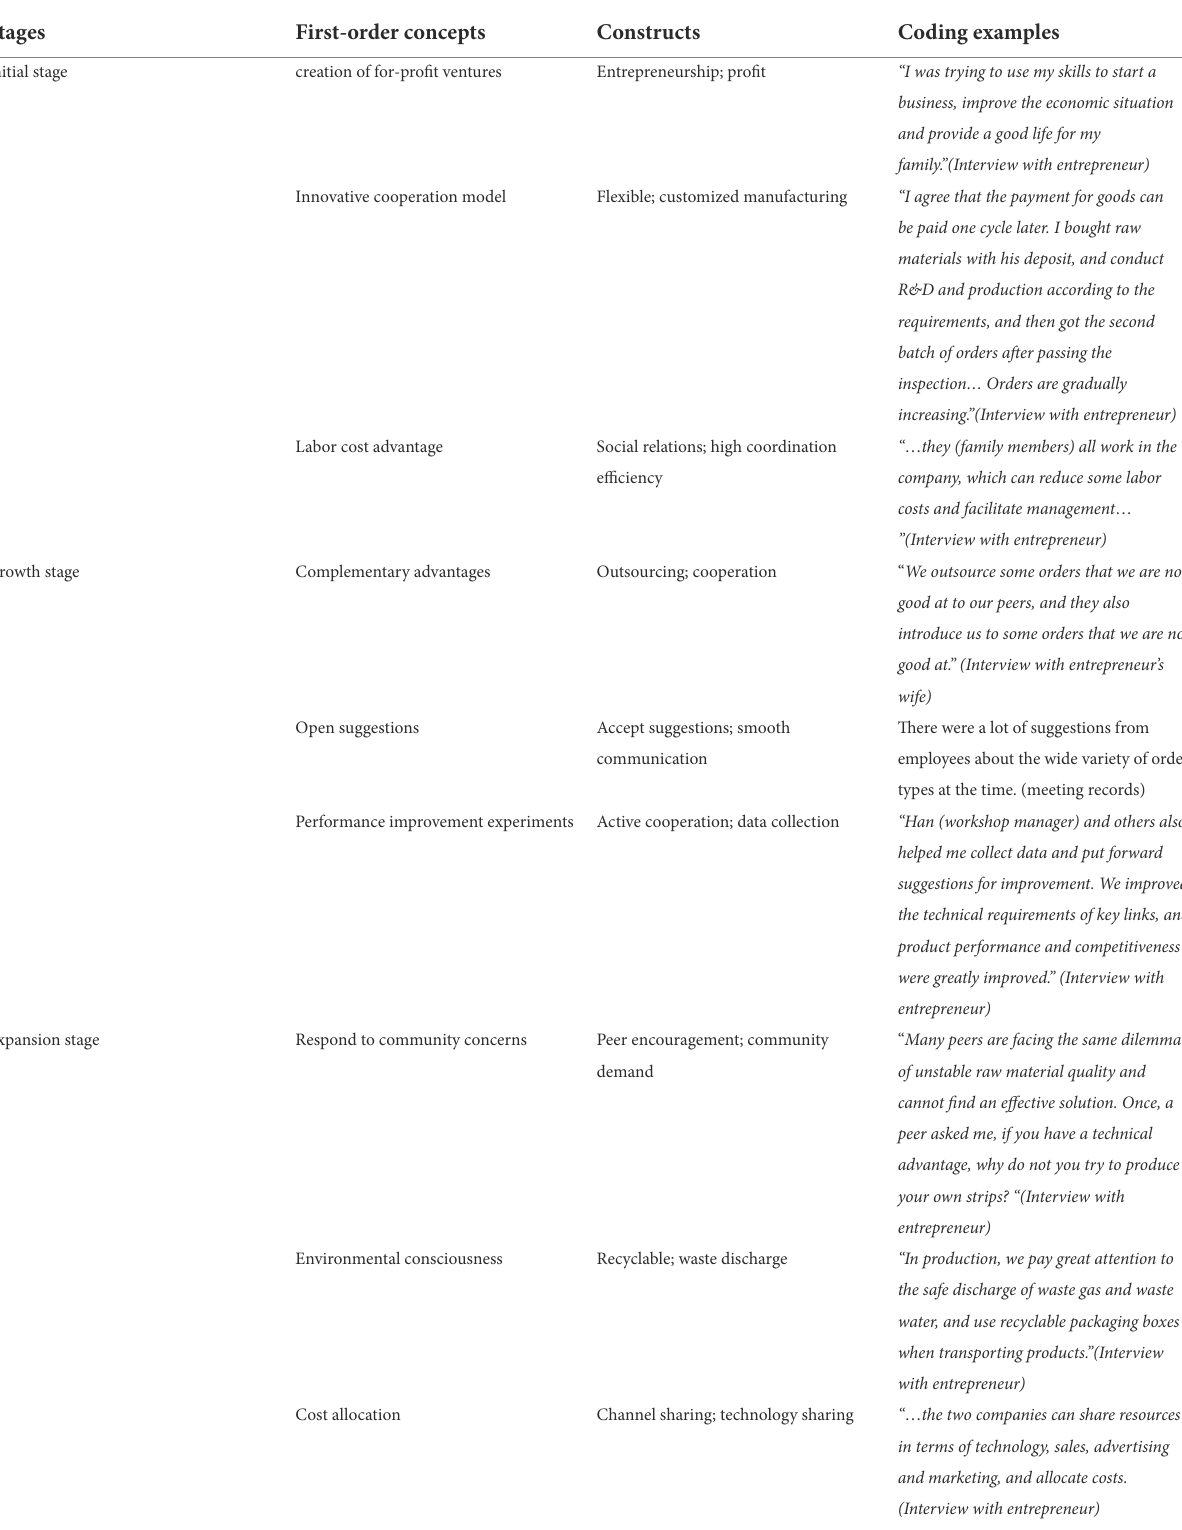
TABLE 2 Example of some first-order concepts generated by open